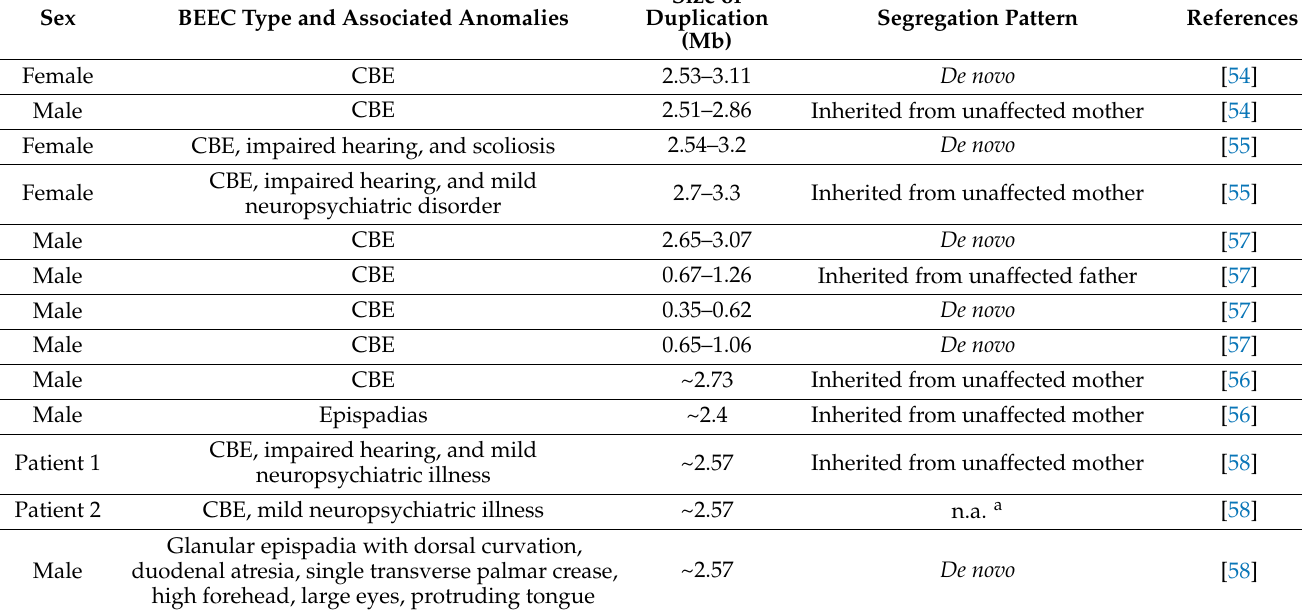
Table 3. 22q11.21 duplications previously reported associated with